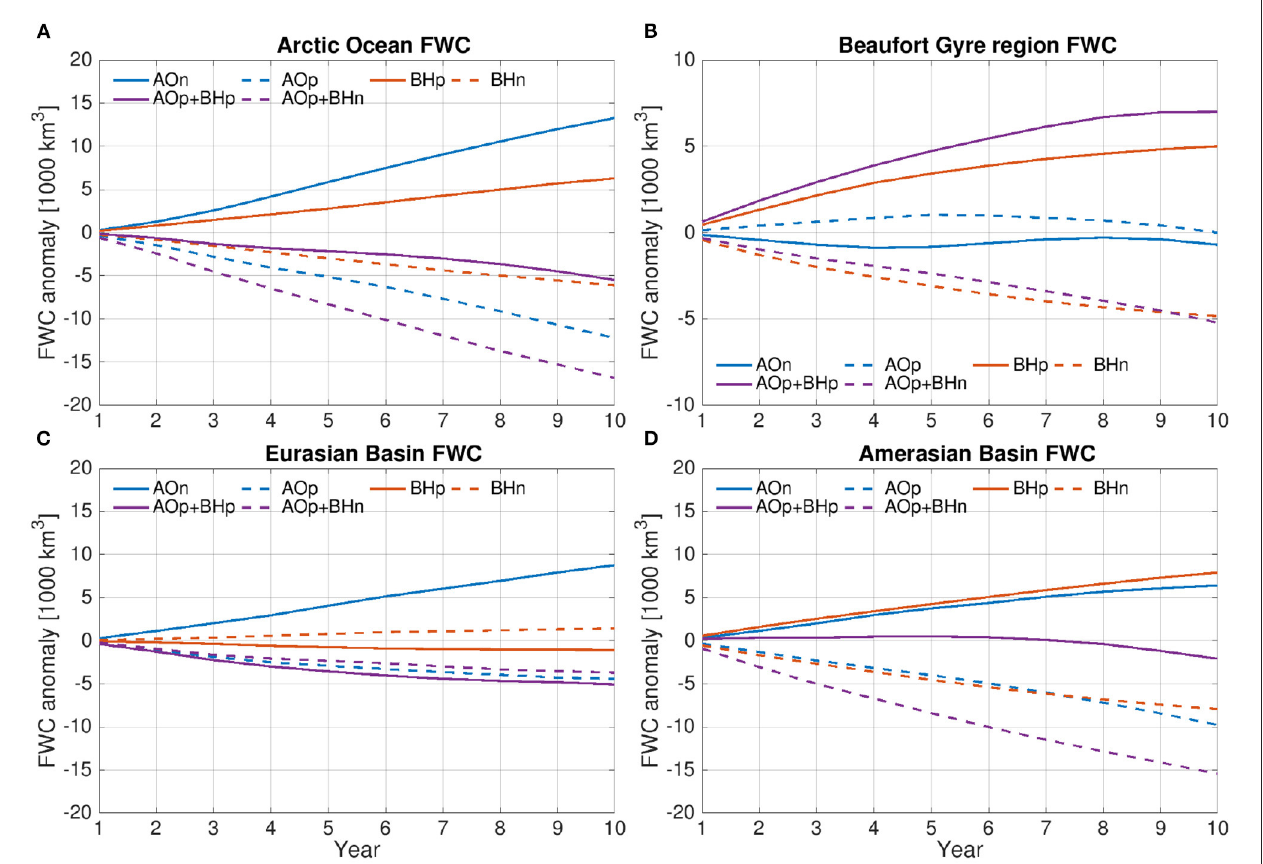
FIGURE 5 | (A) Time series of the Arctic Ocean freshwater content (FWC) anomaly relative to the control run. (B–D) The same as (A) , but for FWC anomaly in the Beaufort Gyre region, Eurasian Basin, and Amerasian Basin, respectively.